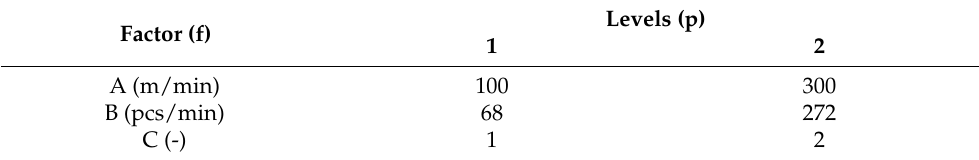
Table 6. Levels for Each Factor.